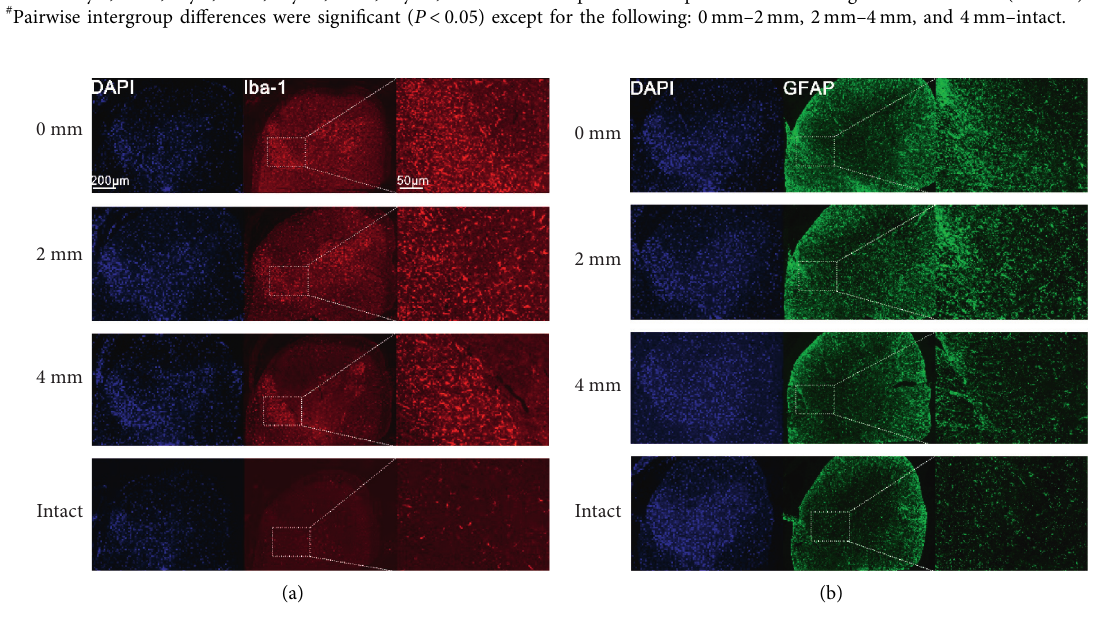
Figure 6: Immunohistochemistry in the C7 dorsal horn of the affected side in the C7 neurotomy subgroups. (a) Ionized calcium-binding adaptor molecule 1 (Iba-1) on day 3. (b) Glial fibrillary acidic protein (GFAP) on day